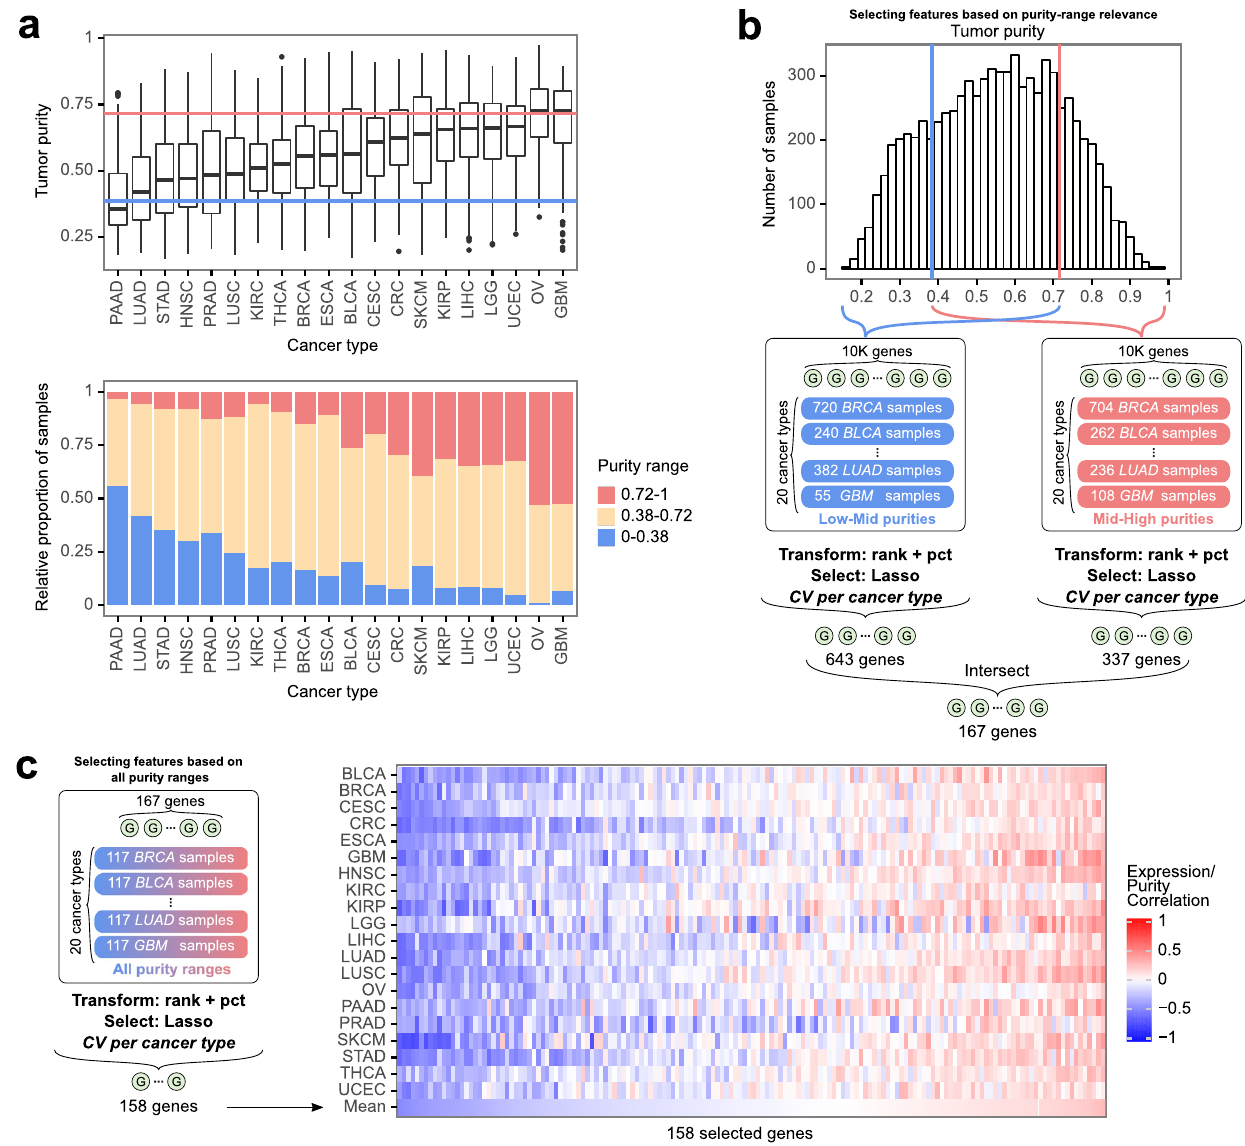
Fig. 2 Feature selection to account for cancer type and tumor purity imbalance. a Boxplots of the genomics-based tumor purity across 20 cancer types from TCGA, blue and red lines marking the bottom/top 20% purity samples; bar plots of the genomics-based tumor purity separated into low, medium, and high purity ranges. b The fi rst step of the feature selection strategy: lasso feature selection, cross-validated on cancer types as folds, was performed separately on low-mid (0.17 – 0.72 purities) and mid-high (0.38 – 0.97) purity range samples, the two feature sets were intersected resulting in 167 genes. c The second step of the feature selection strategy: using the features from the fi rst step, lasso feature selection was iteratively performed across all purity ranges, cross-validated on cancer types as folds, resulting in 158 gene features used for the fi nal model. In the boxplots in ( a ), the lower and upper hinges correspond to the fi rst and third quartiles, the upper whisker extends to the largest value no further than 1.5 of inter-quartile range from the hinge, the lower whisker extends to the smallest value no further than 1.5 of inter-quartile range from the hinge, and points beyond the end of the whiskers are plotted